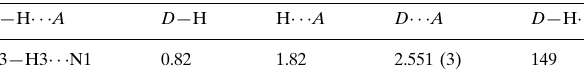
Hydrogen-bond geometry (A˚ , (cid:2)